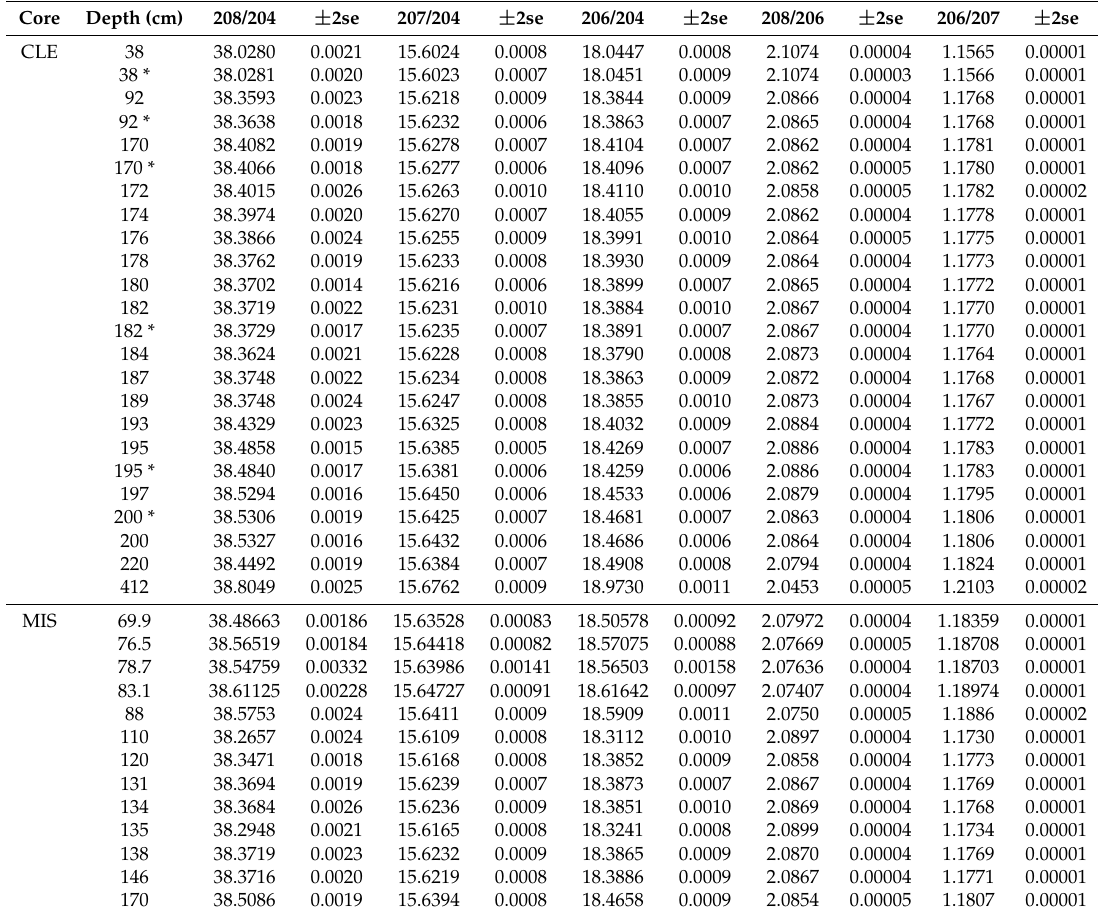
Table 1. Pb isotope data of the CLE and MIS cores measured MC-ICP-MS. * correspond to duplicate